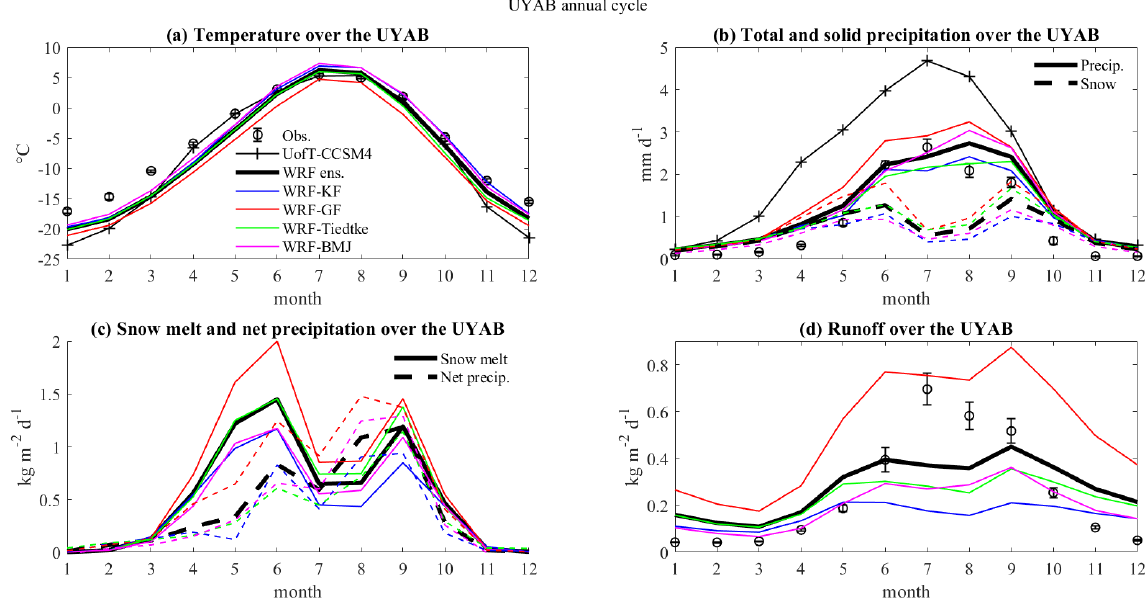
Figure 9. The same as in Fig. 8 but for the UYAB.